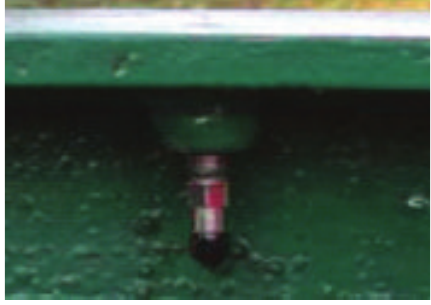
Figure 3: Pressure